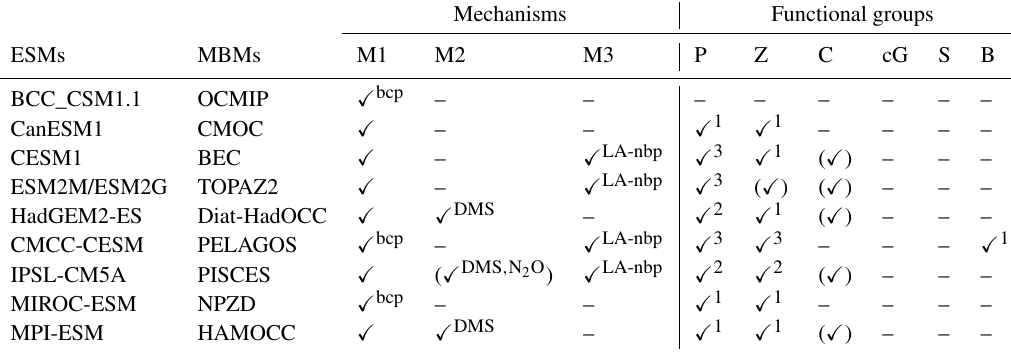
Table 2. Different marine biosphere modules (MBMs) in Earth system models (ESMs) that participated in CMIP5 (Arora et al., 2013; Laufkötter et al., 2015): OCMIP: Wu et al. (2013); CMOC: Christian et al. (2010); BEC: Moore et al. (2013); TOPAZ2: Supplement of Sarmiento et al. (2010), Dunne et al. (2013); Diat-HadOCC: Palmer and Totterdell (2001); HadGEM2-ES: The HadGEM2 Development Team (2011); PELAGOS: Vichi et al. (2007), Vichi et al. (2011); PISCES: Aumont and Bopp (2006), Lengaigne et al. (2009), Aumont et al. (2015); NPZD: Watanabe et al. (2011), Kawamiya et al. (2000); HAMOCC: Maier-Reimer et al. (2005), Ilyina et al. (2013). We only use the most recent peer-reviewed reference of each MBM. MBMs are only listed once, even though some of them are used in more than one ESM. The numerals refer to the biologically driven mechanisms while P, Z, C, cG, S, and B denote the organism groups phytoplankton, zooplankton, calcifiers, coastal gas producers, surface mat producers, and bacteria, respectively. Organism groups that are not explicitly described but parameterized are in parentheses. Checkmarks with additions refer to the biogeochemical carbon pump (bcp), DMS or N 2 O (specific SCCs), light absorption by neutrally/negatively buoyant phytoplankton (LA-nbp), or the numbers of explicitly described functional groups. In PISCES, the SCCs are not included by default but available through additional